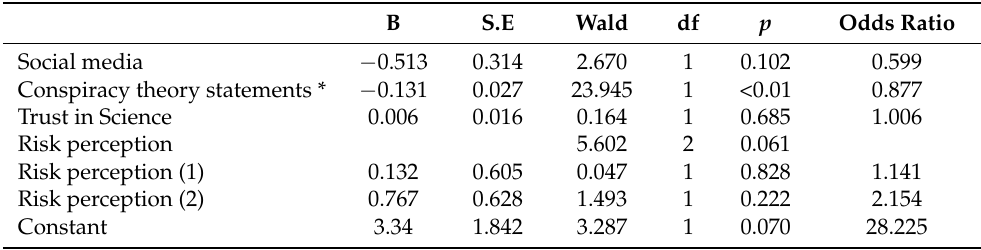
Table 3. Logistic regression predicting the likelihood of vaccination